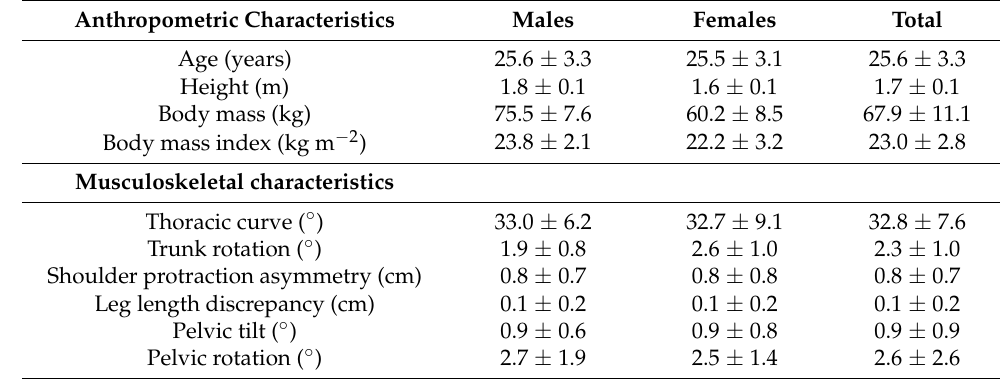
Table 1. Means ± standard deviations of the anthropometric and musculoskeletal characteristics of the study